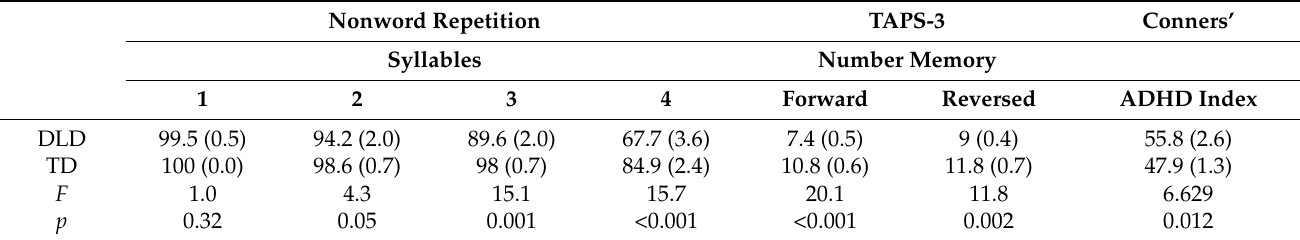
Table 2. Group means for nonword repetition, auditory processing (Test of Auditory Processing Skills—3rd edition, TAPS-3), and attention deficit/hyperactivity disorder (ADHD) symptoms (Conners’ Rating Scales).